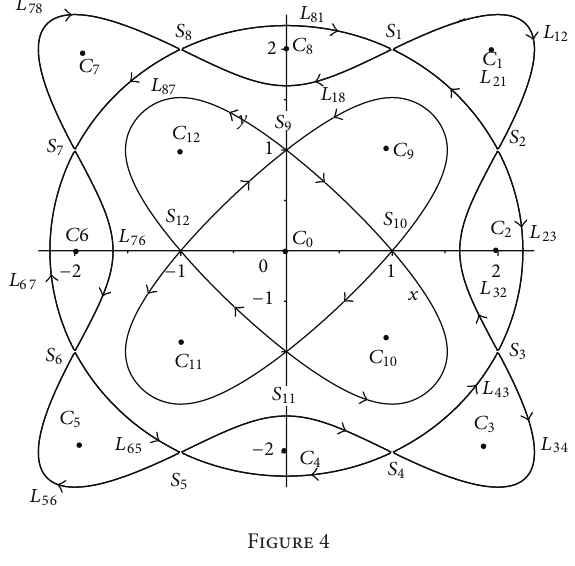
̃Γ 1 consists of = (1, −2) , 𝑆 4